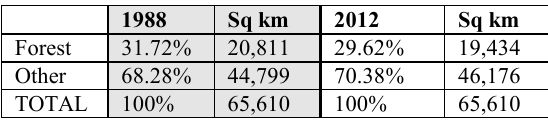
Table 4. Assessment of forest area changes.